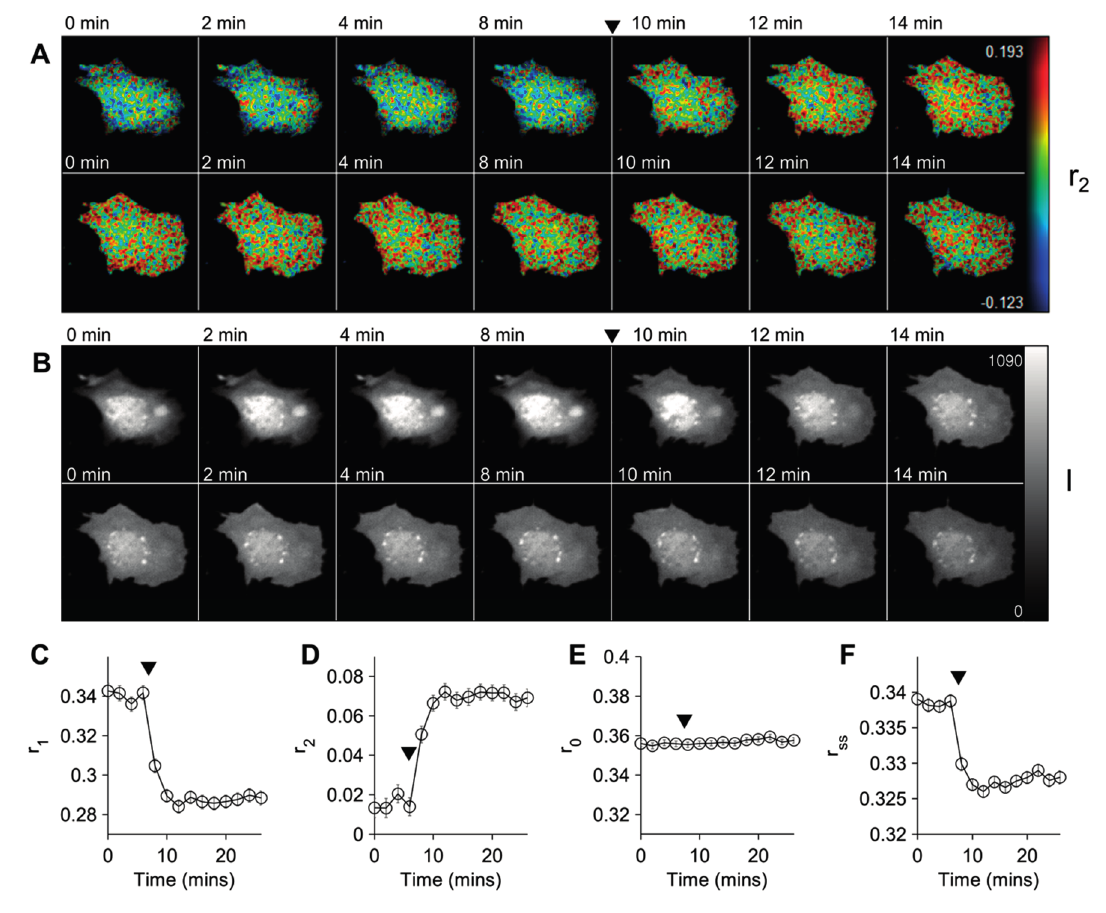
Figure 2. Homo-FRET anisotropy response of mCherry-Akt-PH to PDGF-BB stimulation. A Mouse embryonic fibroblasts (MEF) transfected with mCherry-Akt-PH was imaged on the polarisation resolved microscope at two minute intervals and stimulated with 50 ng/mL PDGF-BB after 8 min (indicated by black triangles). The data was fitted to bi-exponential anisotropy decay model. ( A ) Intensity merged false colour map of the anisotropy component associated with FRET r 2 ; ( B ) Integrated intensity image; ( C – F ) Values of ( C ) anisotropy component due to rotational correlation time r 1 ; ( D ) anisotropy component associated with FRET r 2 , ( E ) initial anisotropy r 0 and ( F ) steady-state anisotropy r ss averaged across each image. Error bars represent 95% confidence limits across the image, adjusted for smoothing. The cell shown is representative of a series of 10 experiments, of which 7 cells showed a similar